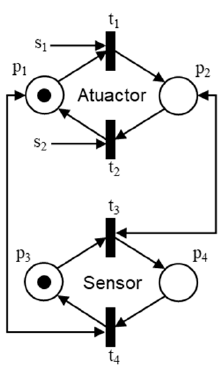
Figure 5. Model of the actuator and valve sensor V31 for the closed state.